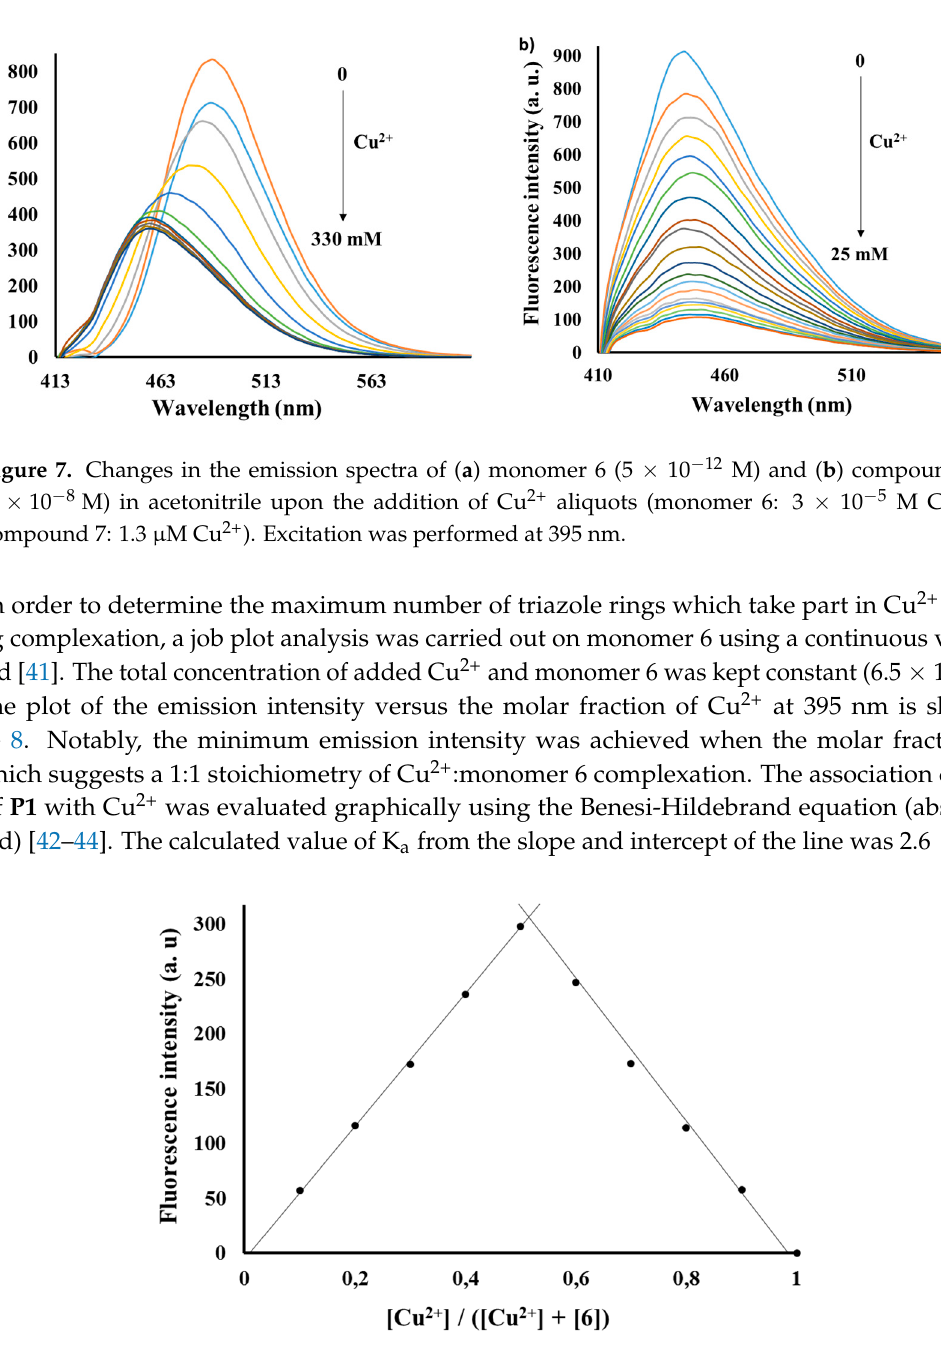
Figure 8. A job plot for monomer 6-Cu 2+ complexation with a constant total concentration of 6.5 × 10 − 11 M in acetonitrile. Excitation was performed at 385 nm.